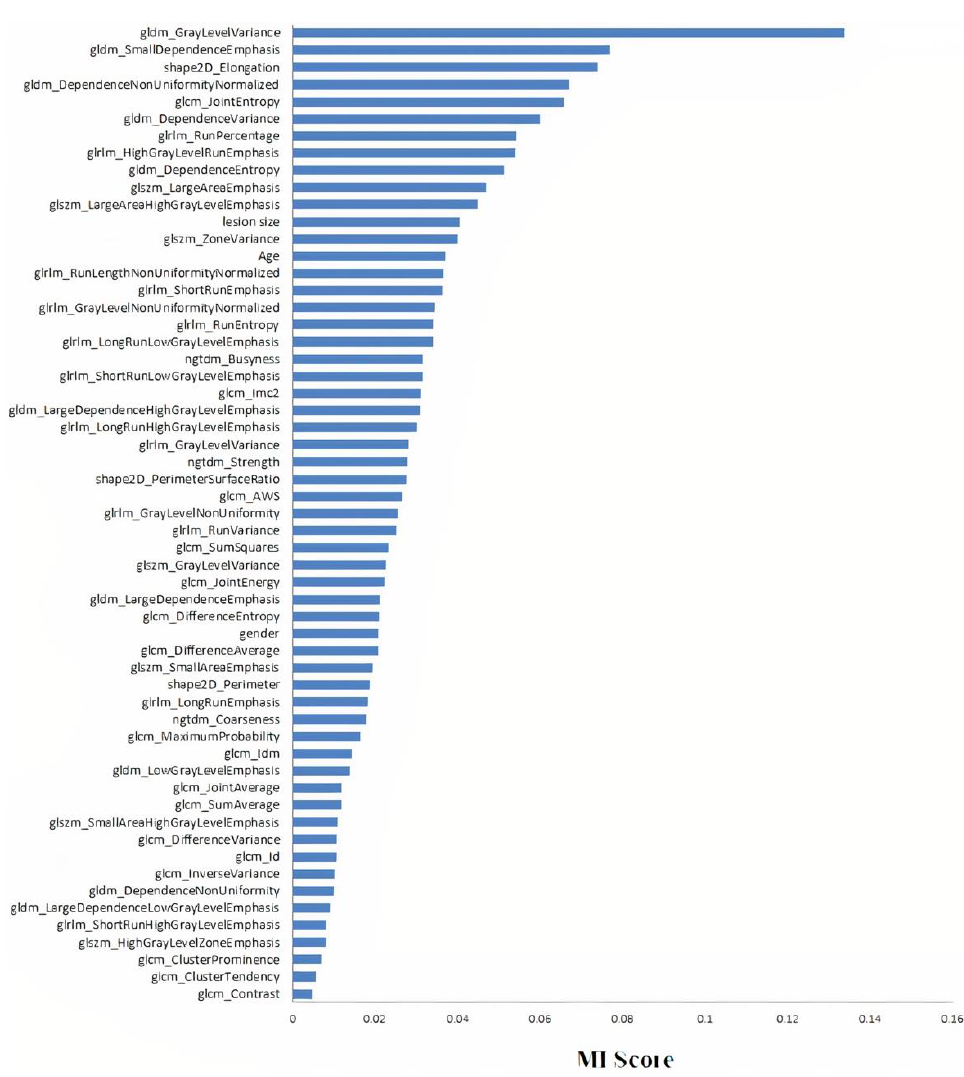
Figure 12. Feature selection of radiomics feature and patient data-based model.